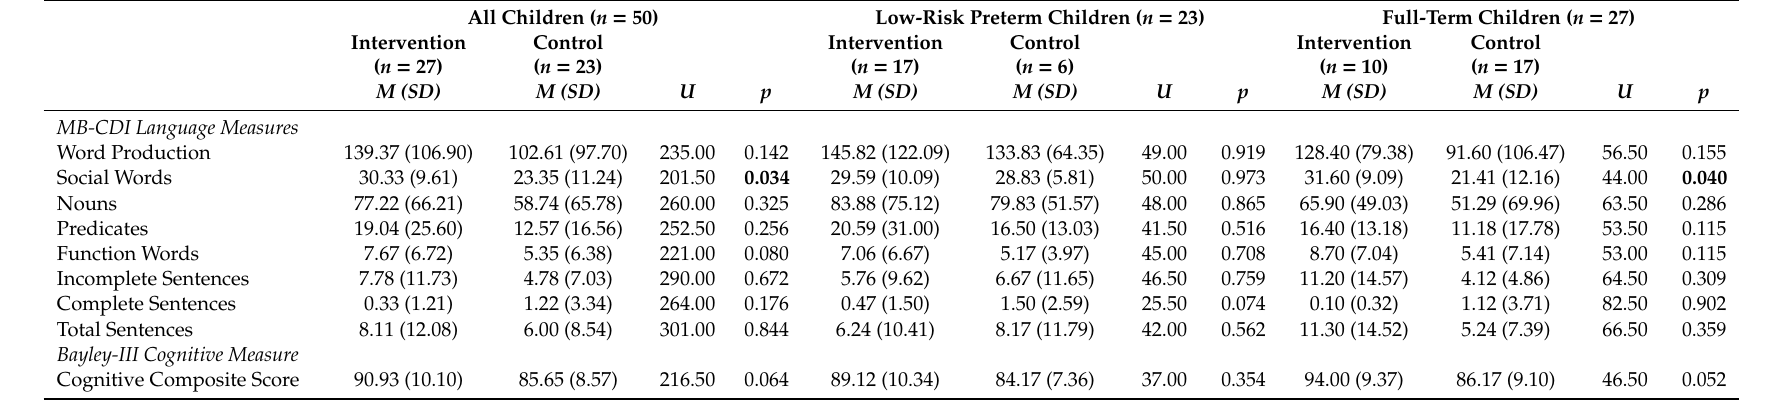
Table 3. Cognitive and language skills of children at the pre-intervention assessment.